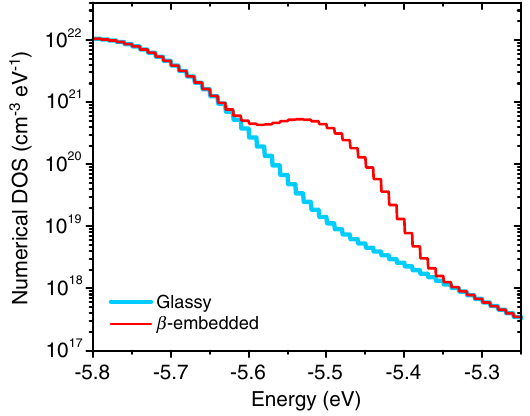
FIG. 8. Numerical hole DOS functions proposed in the drift- diffusion modeling, for glassy PFO (blue curve) and PFO containing β -phase (red curve), respectively. This set of model DOS is a simplified picture of realistic distributions; however, it nonetheless captures the key features. As an approximation due to relatively low content of β -phase, a direct superposition for constructing the β -embedded DOS is applied. The numerical β -phase feature is centered at 270 meV above the transport level, featuring a breadth of 45 meV and a 5 × 10 20 cm − 3 eV − 1 peak height. The graphs are plotted as piecewise-constant functions to represent the discretization in energy space of the DOS distri- butions that are used in the numerical model. of carrier occupancy in the experimental case due to unintentional variations in the laser pulse intensity, whereas in the simulation case, laser pulse photon flux is kept the same. The crossing observed in the simulated case is